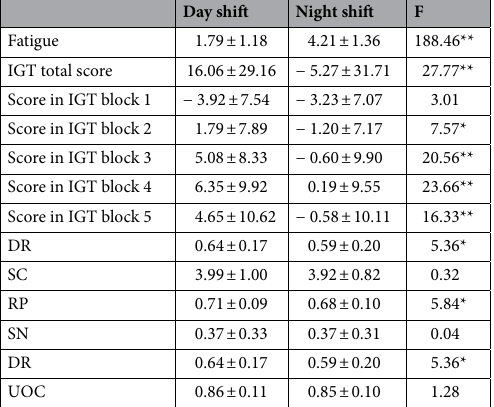
Table 1. Differences in fatigue, IGT, and A-DMC scores in the day and night shifts (n = 107). IGT Iowa Gambling Task, RF resistance to framing, SC resistance to sunk costs, RP consistency in risk perception, SN recognizing social norms, DR applying decision rules, UOC under/overconfidence. *p < 0.05; **p <